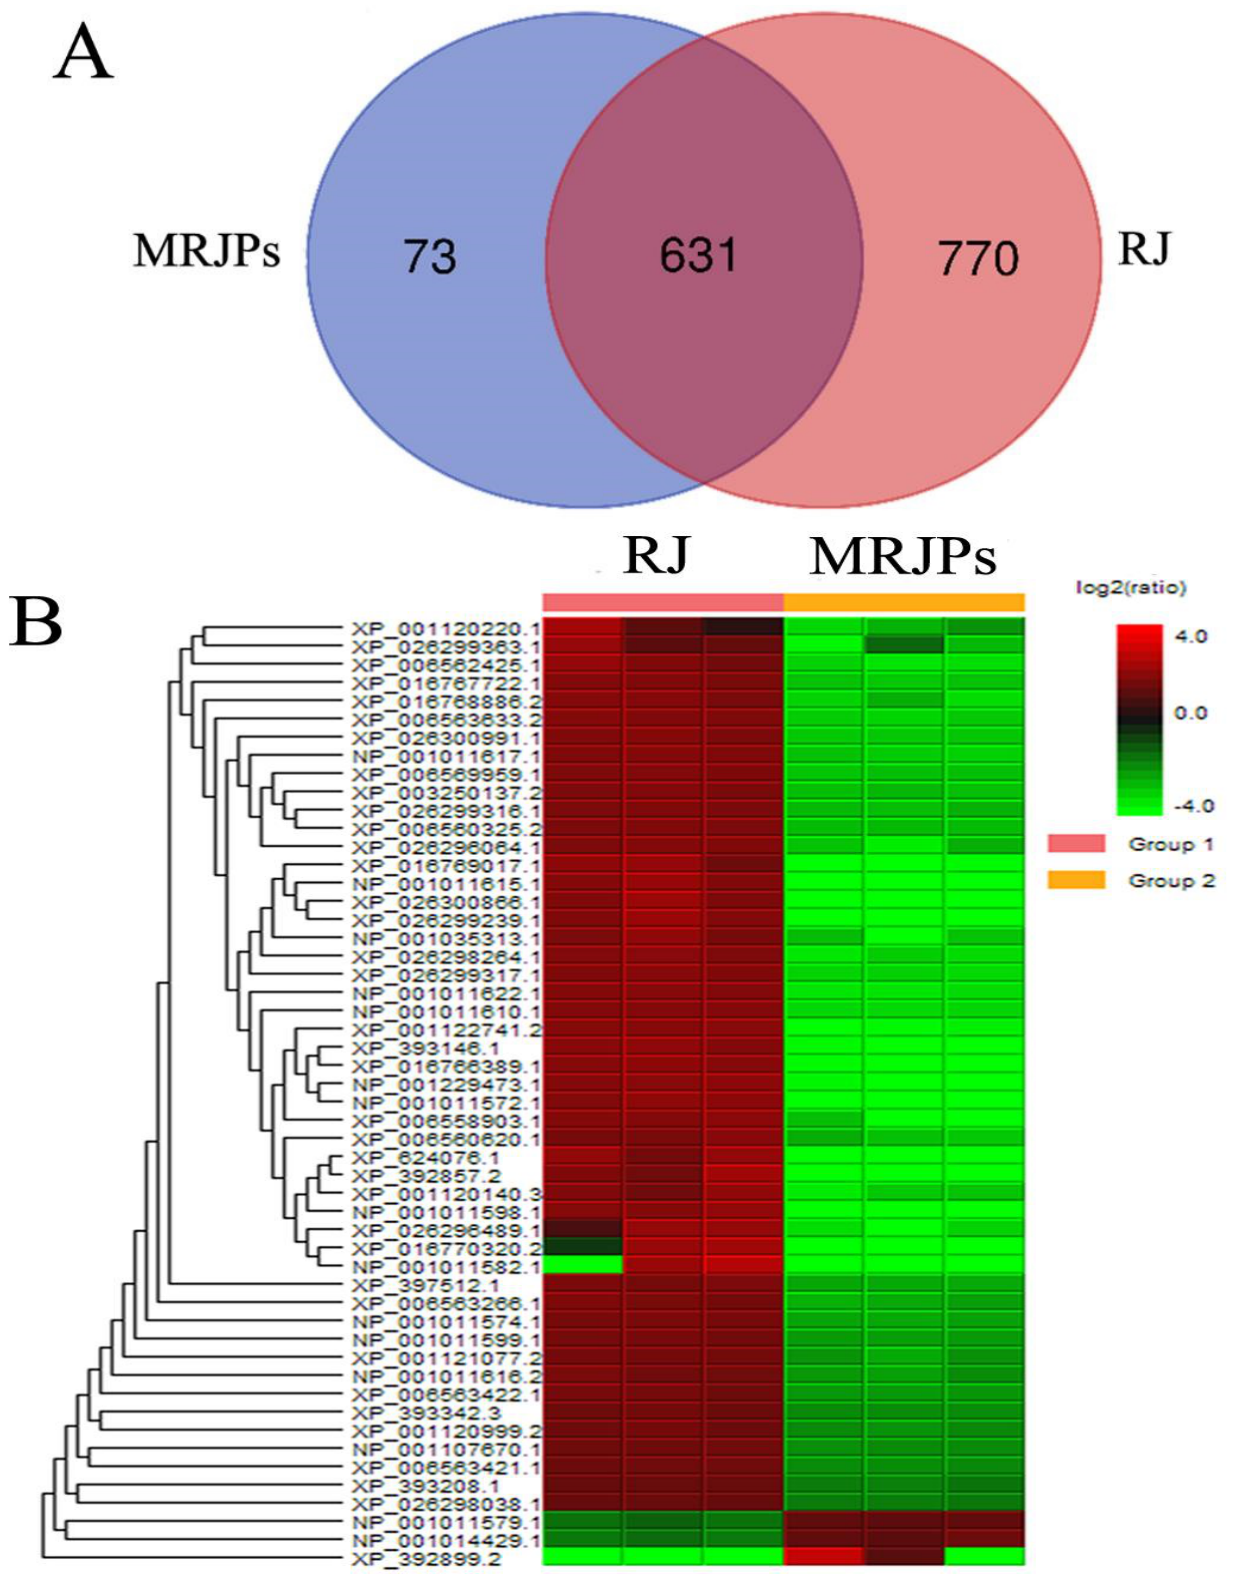
Figure 2. Protein identification and quantification analysis. ( A ) Venn diagram of shared and unique peptides of royal jelly and MRJPs; ( B ) protein cluster analysis of differences in content between royal jelly and MRJPs (fold change >1.5, p value < 0.05).